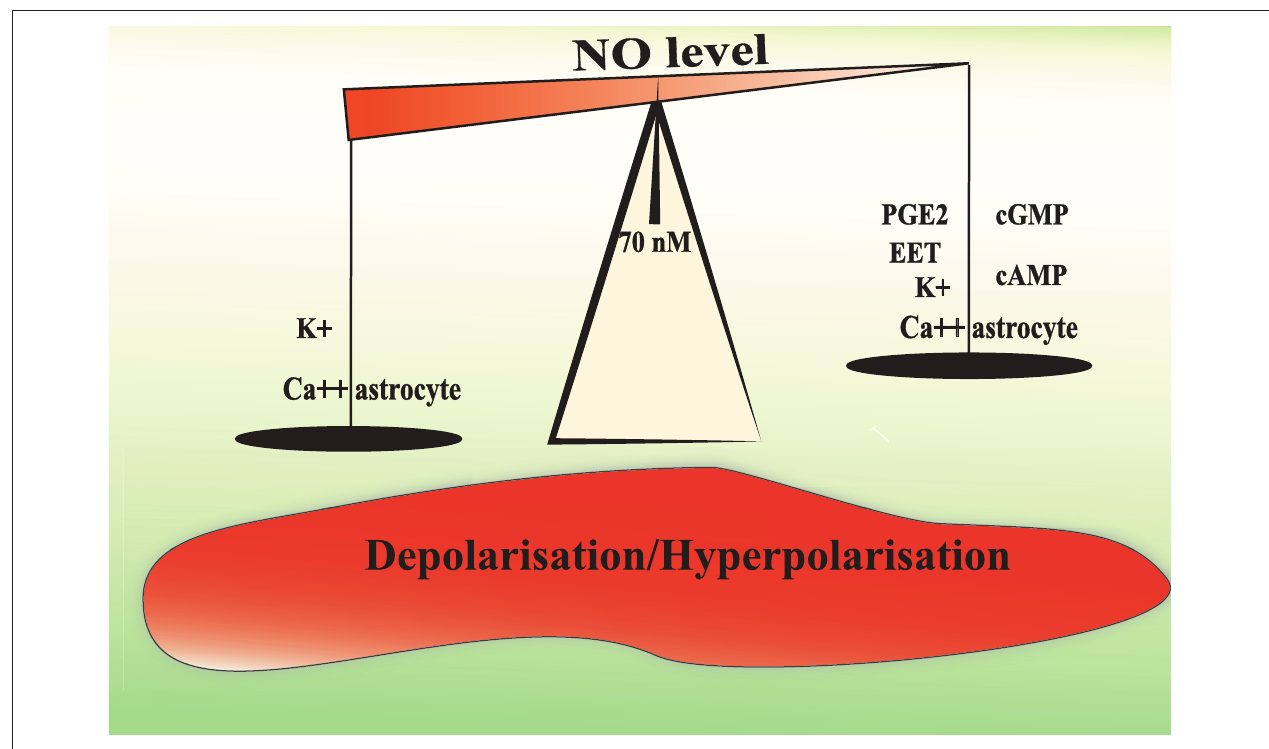
FIGURE 2 | Hypothetical mechanisms underlying the biphasic effect of NO in the modulation of NVC. A moderate or physiological NO increases the release of vasorelaxing factors from the astrocyte and depolarise smooth muscle cells to increase cerebral blood flow. NO levels above 70–80nM may